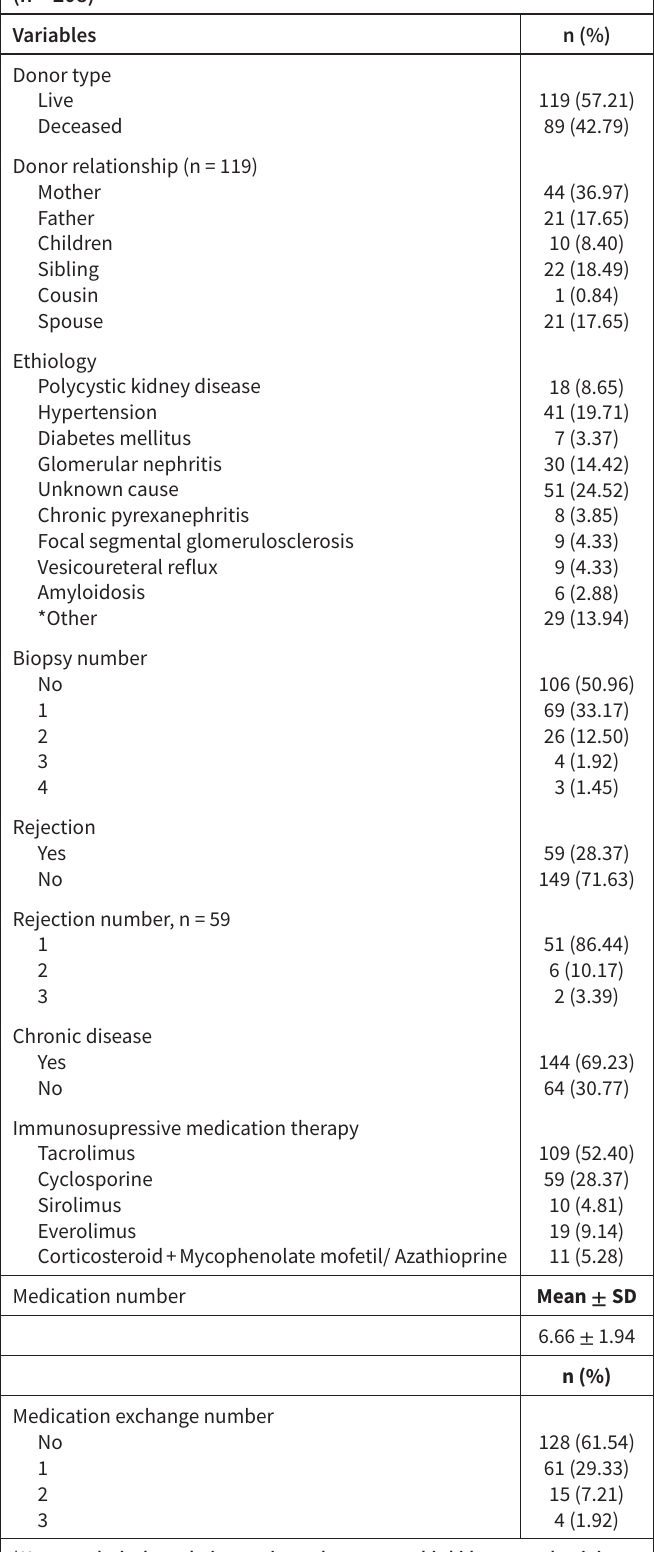
Table 2. Clinical Charecteristics of Kidney Transplant